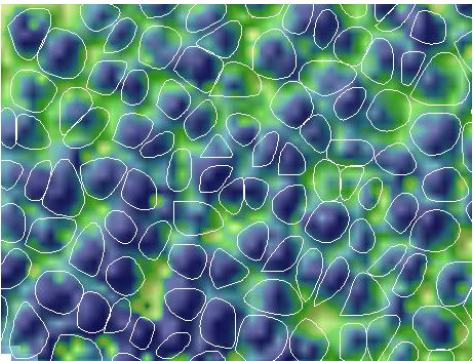
Figure 21. A portion of the area with properly segmented crown Some of the delineated tree crown is over segmented as shown in Figure 22.